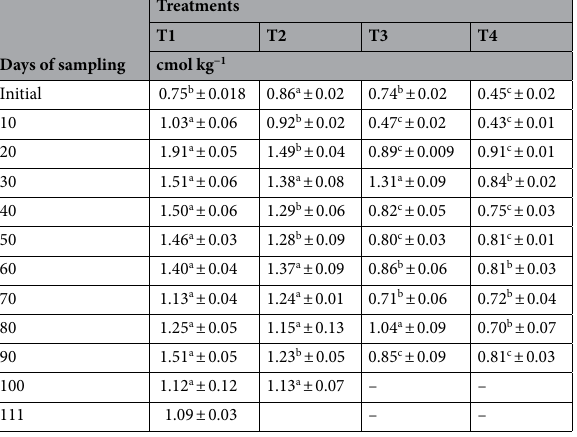
Table 8. Chicken litter biochar on exchangeable acidity at one hundred and eleven days after transplanting of MR219. Different letters within a row indicates significant difference between means of four replicates ± standard error using Tukey’s test at p ≤